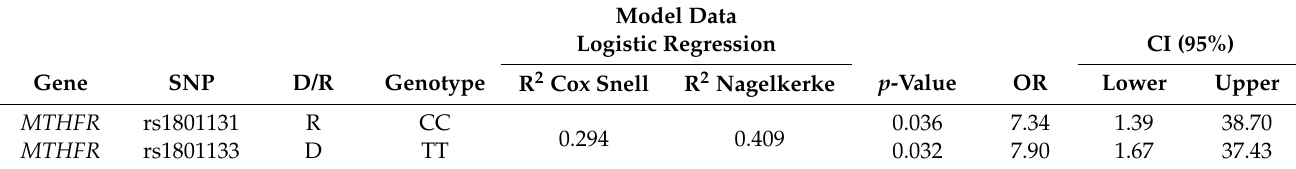
Table 3. Pharmacogene variants significantly associated with survival rates after FDR calculation employing the p -values of selected variables in exitus and cancer risk studies by logistic and Cox re-